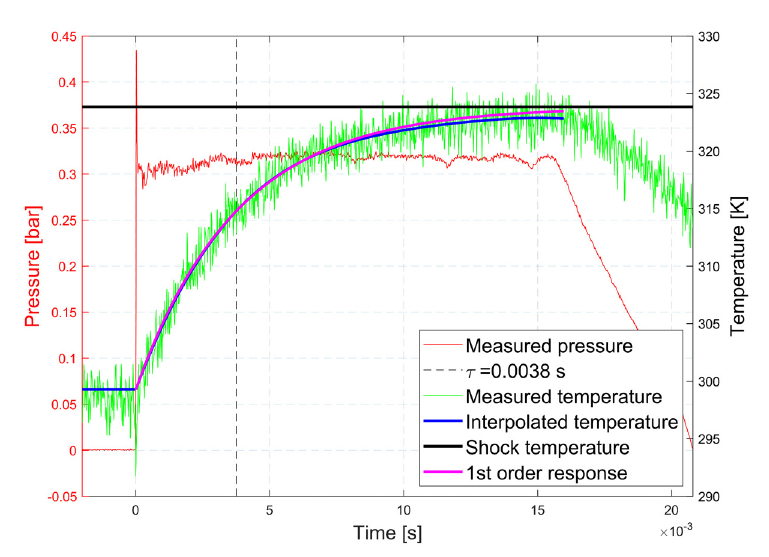
Figure 6. Fast response thermocouple calibration.